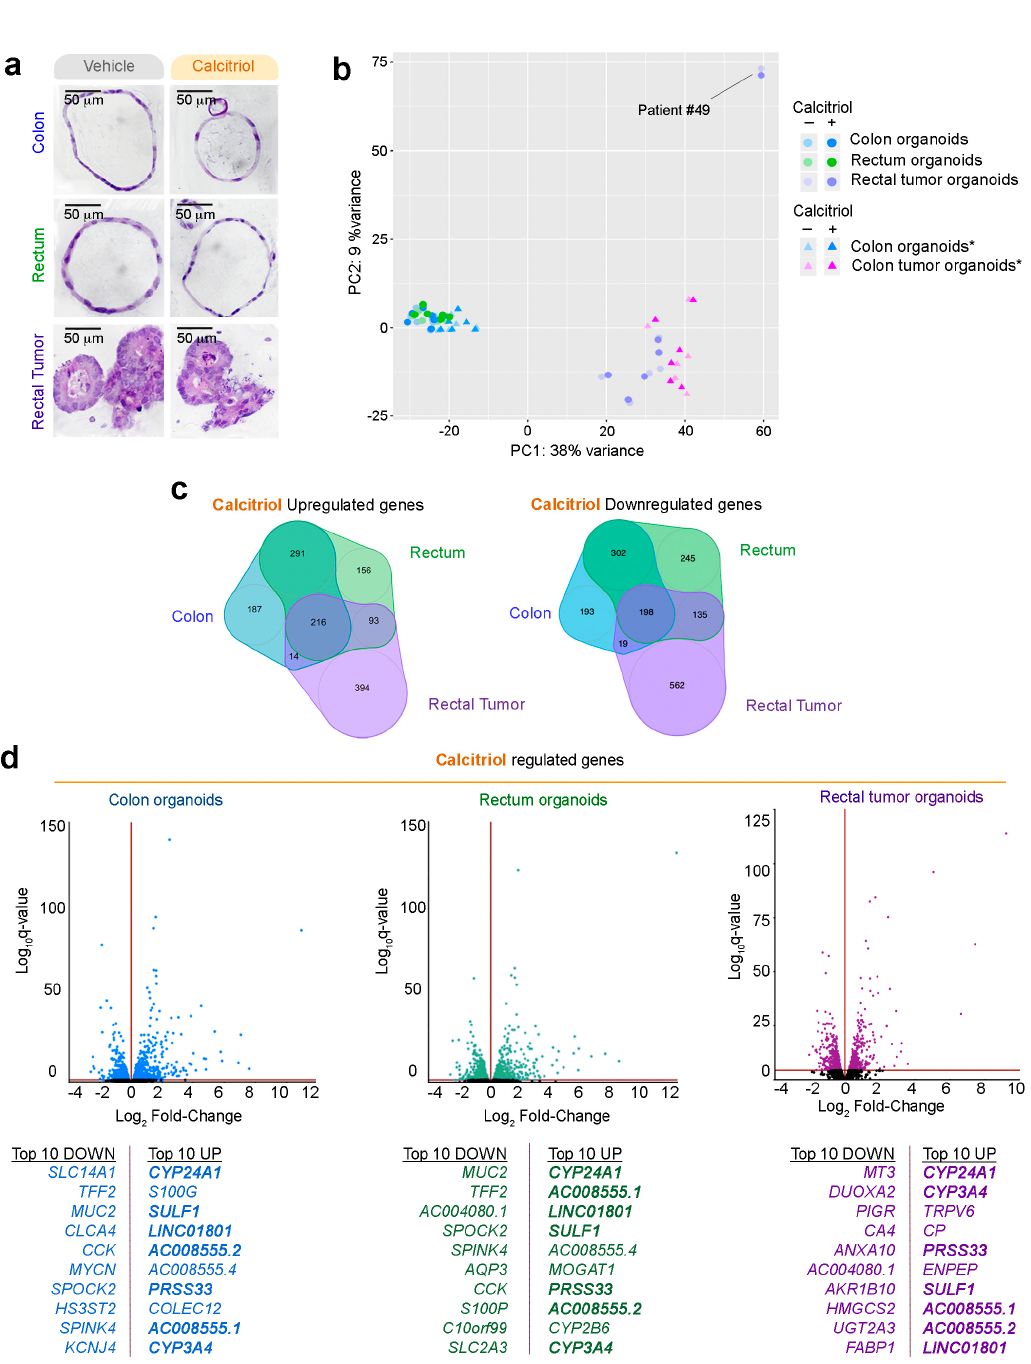
Figure 4. Effect of calcitriol on human normal colon, rectum, and rectal tumor organoids. ( a ) Morphology analysis by H&E staining of each type of patient-derived organoids cultured for 96 h in the presence of 100 nM calcitriol or vehicle. Scale bar = 50 μ m. ( b ) PCA of raw RNA-seq data from organoids treated with calcitriol or vehicle (17 patients/30 organoid cultures). * RNA-seq data (six patients) for normal and tumor colon organoids were included from a previous publication; transcriptome data from GSE100785 [33]. ( c ) Venn diagram showing the overlap among genes showing a significantly altered expression in normal and tumor organoids. The numbers of genes in each group are indicated. ( d ) Volcano plots showing calcitriol-regulated genes in organoids derived from a normal colon (blue), normal rectum (green), and rectal tumor (purple). Top-10 up/down regulated genes in normal colon, normal rectum, and rectal tumor organoids are listed. Common regulated genes in the three types of cultures are shown in bold.